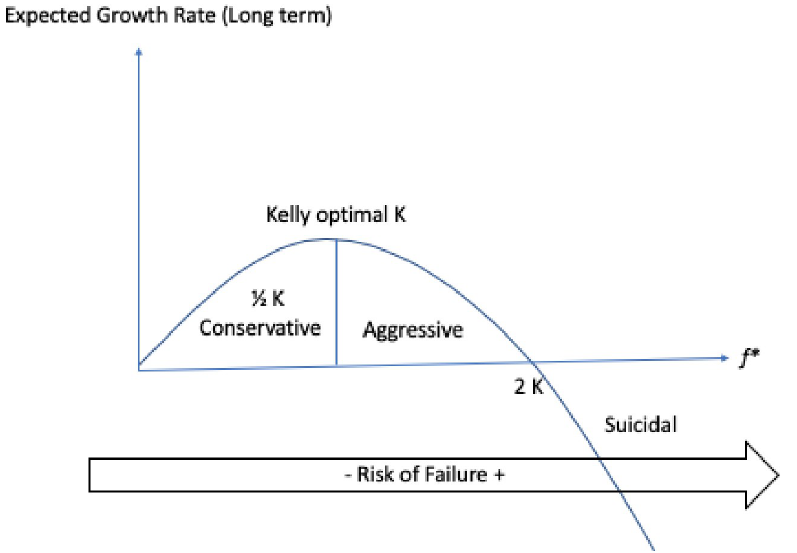
Fig 19. Maximization of entropy in random